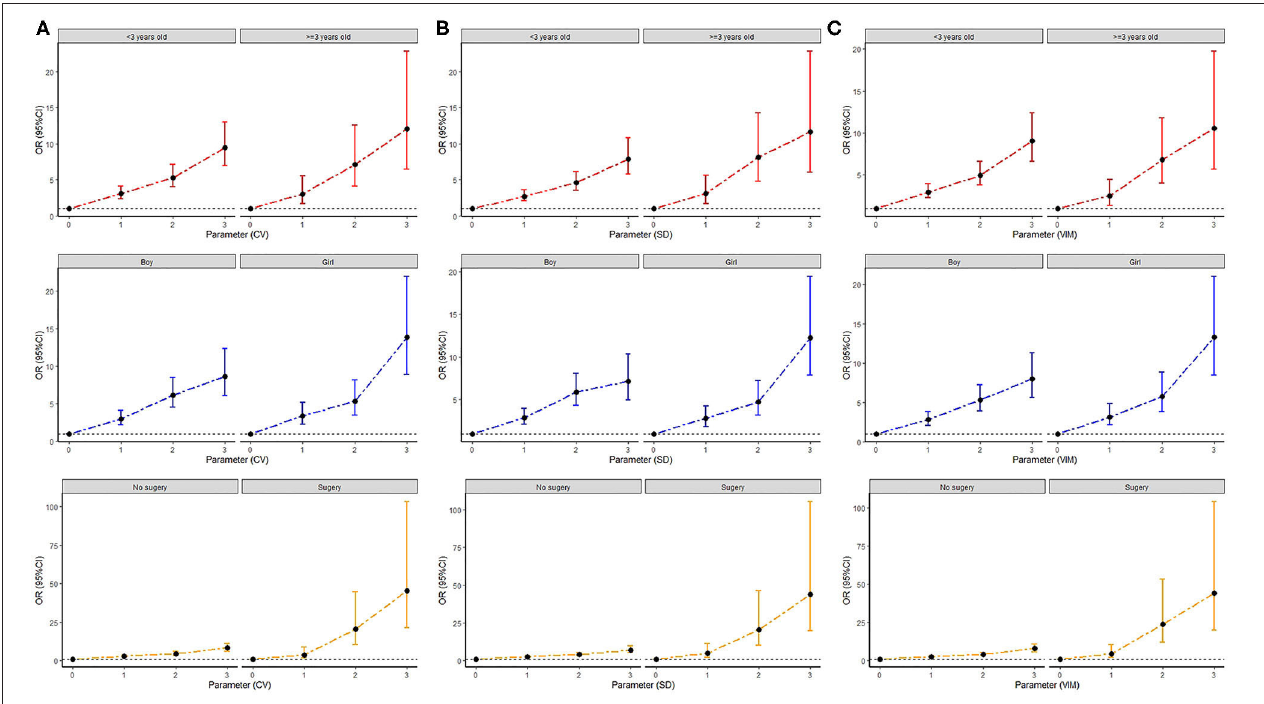
FIGURE 2 | The odds ratios and 95% confidence interval for in-hospital mortality by number of parameters with high variability defined as the highest quartile of (A) CV of electrolytes; (B) SD of electrolytes; and (C) VIM of electrolytes. Subgroup analyses according to age, sex, and surgical experience. CV, coefficient of variation; SD, standard deviation; VIM, variability independent of the